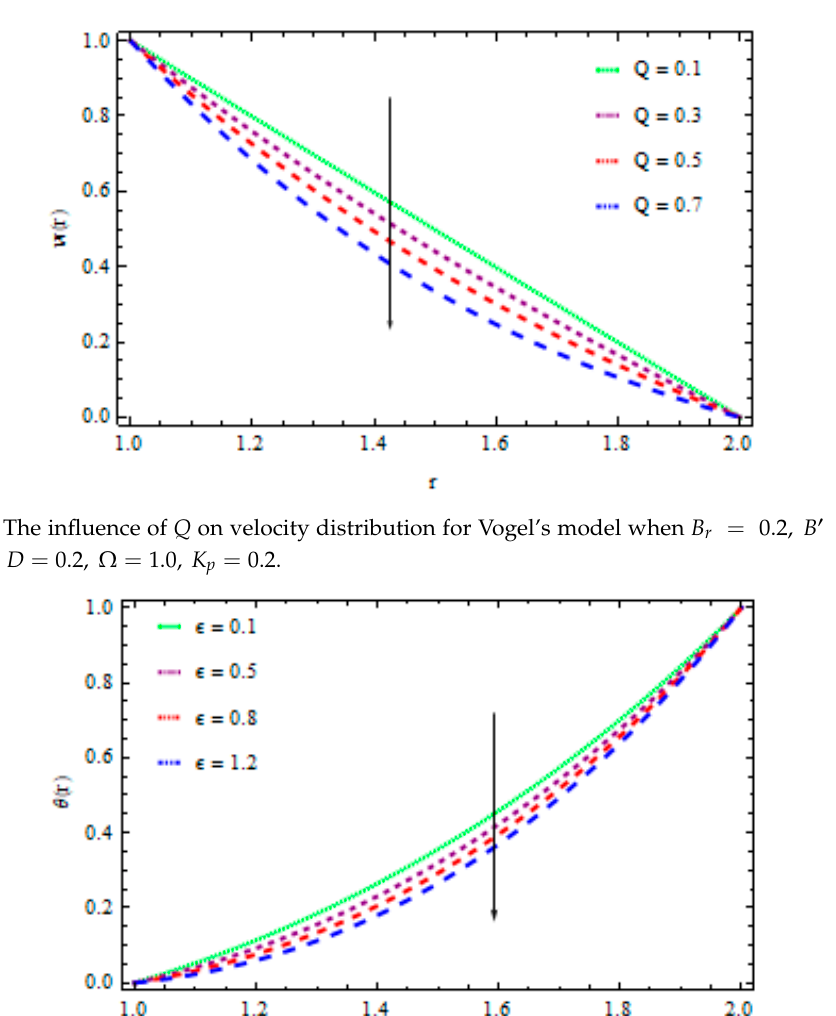
Figure 8. The influence of ε on temperature when Q = 0.6, B r = 1.4, N = 0.01, K p = 0.6.